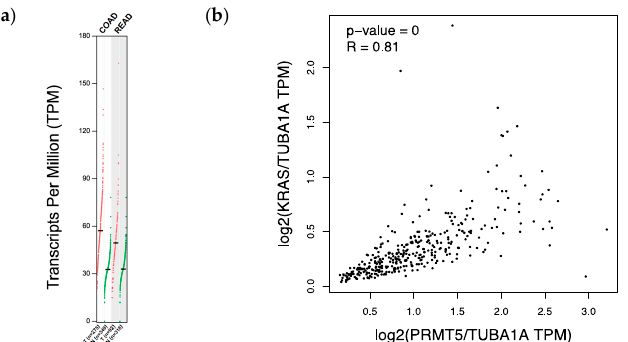
Figure 1. PRMT5 expression is shown to be upregulated, as well as positively correlated with KRAS expression, in CRC patient datasets. ( a ) RNA-Seq data of CRC patients from the TCGA database using the GEPIA website showing that PRMT5 is overexpressed ( q < 0.01) in CRC patient tumor samples when compared to normal colon and rectum tissue; ( b ) RNA-Seq data of CRC patients from the TCGA database using the GEPIA website displaying that PRMT5 expression is strongly positively correlated ( p < 0.005, R = 0.81) with KRAS expression in CRC patient tumor samples.